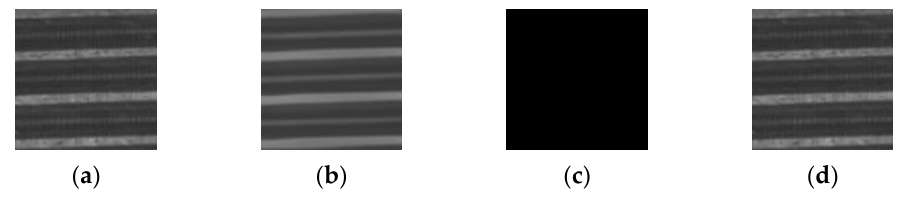
Figure 11. The meaning of the normal patch for two networks (unit: 0.03 mm/pixel). ( a ) Original patch image; ( b ) reconstruct patch image; ( c ) residual patch image; ( d ) superimposed patch image.